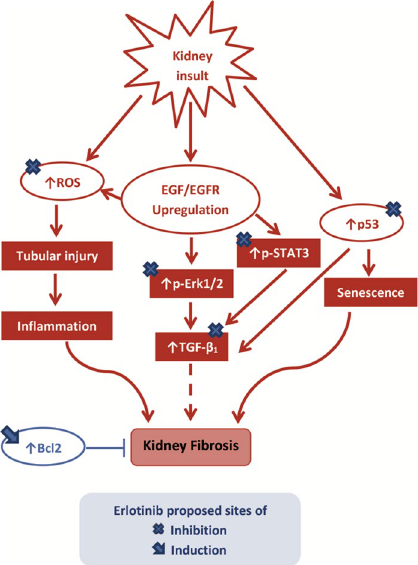
Figure 7. Graphical abstract. Bcl B-cell lymphoma, EGF epidermal growth factor, EGFR epidermal growth factor receptor, p-STAT3 phosphorylated signal transducer and activator of transcription-3, p-ERK phosphorylated extracellular signal-regulated kinase, ROS reactive oxygen species, TGF transforming growth factor.